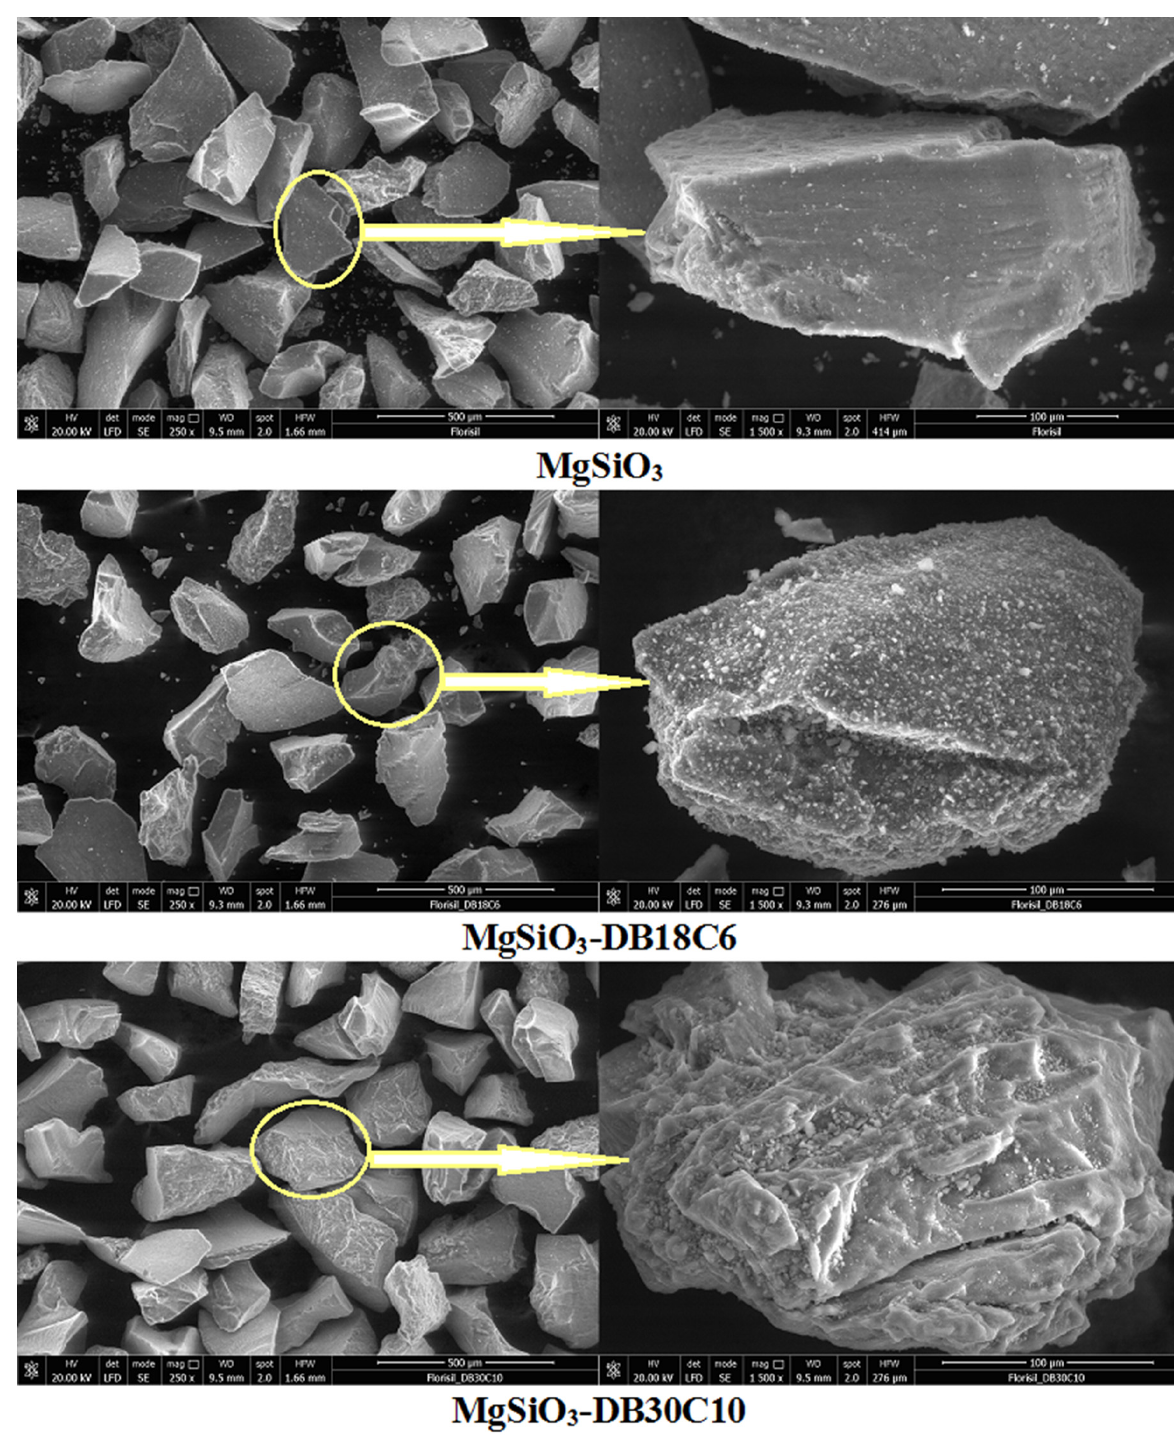
Figure 1. SEM images of the adsorbent before and after